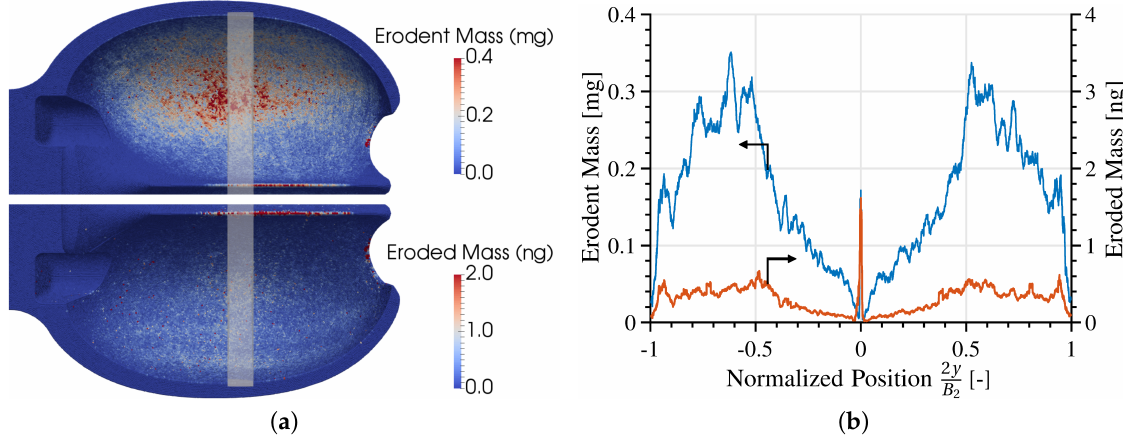
Figure 4. Erodent mass (i.e., the amount of sediment that impacted) and eroded mass (i.e., the amount of base material removed), on the bucket surface ( a ) and on the pitch diameter position ( b ). The values presented in ( b ) are taken from the rectangular stripe illustrated in ( a